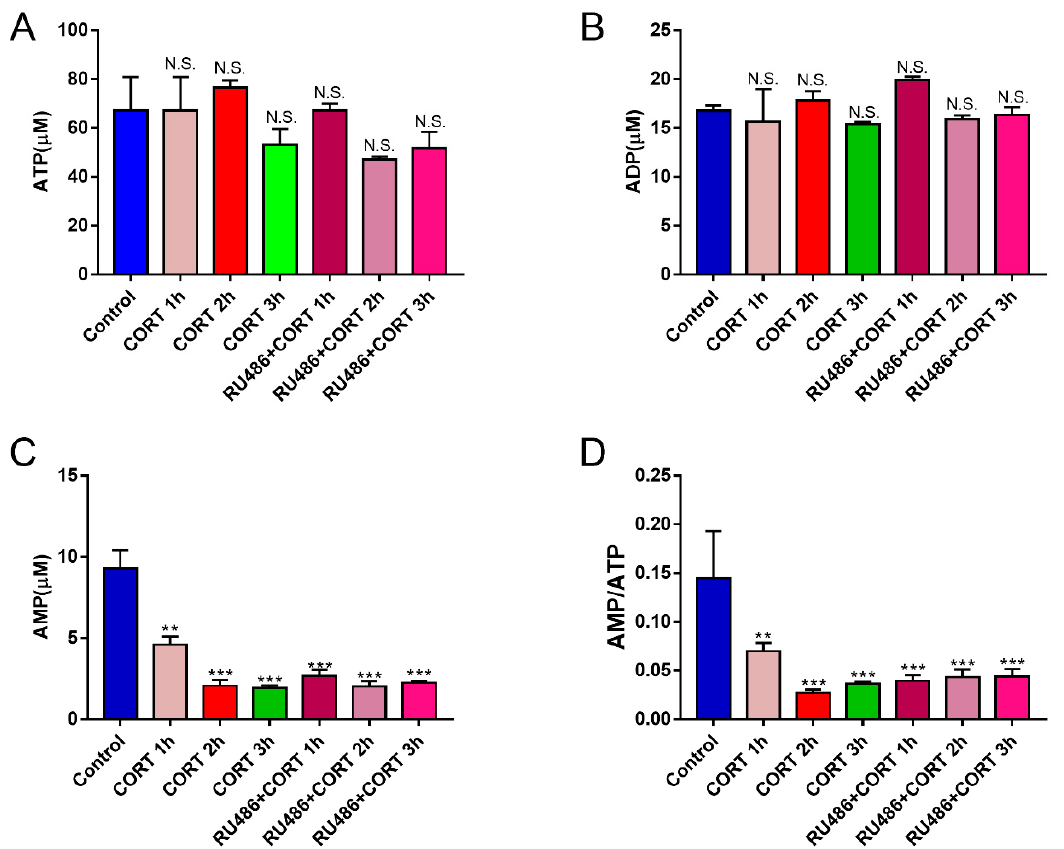
Figure 6. The ATP, ADP, and AMP levels ( A–C ) and the trend of ATP, ADP, and AMP levels in HT22 cells after cortisol treatment at different times (0–3 h) were measured, and the ratio of AMP to ATP was determined ( D ). The results are expressed as the mean ± SD (n = 3) in each independent experiment analyzed by one-way analysis of variance. NS: not significant; ** p < 0.01; *** p < 0.001.